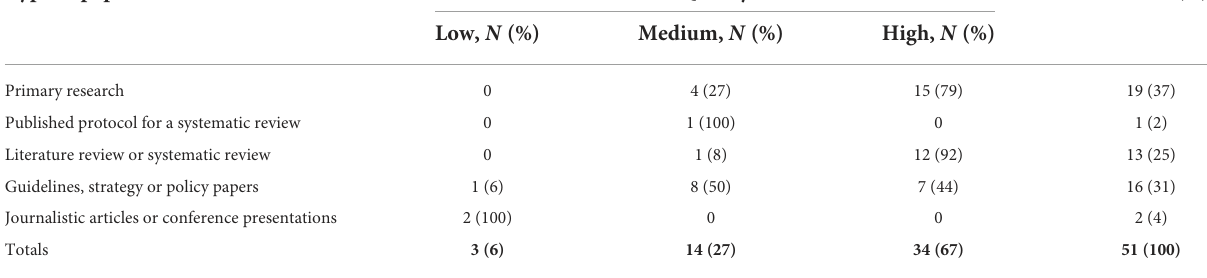
TABLE 3 Summary of quality assessment by type of